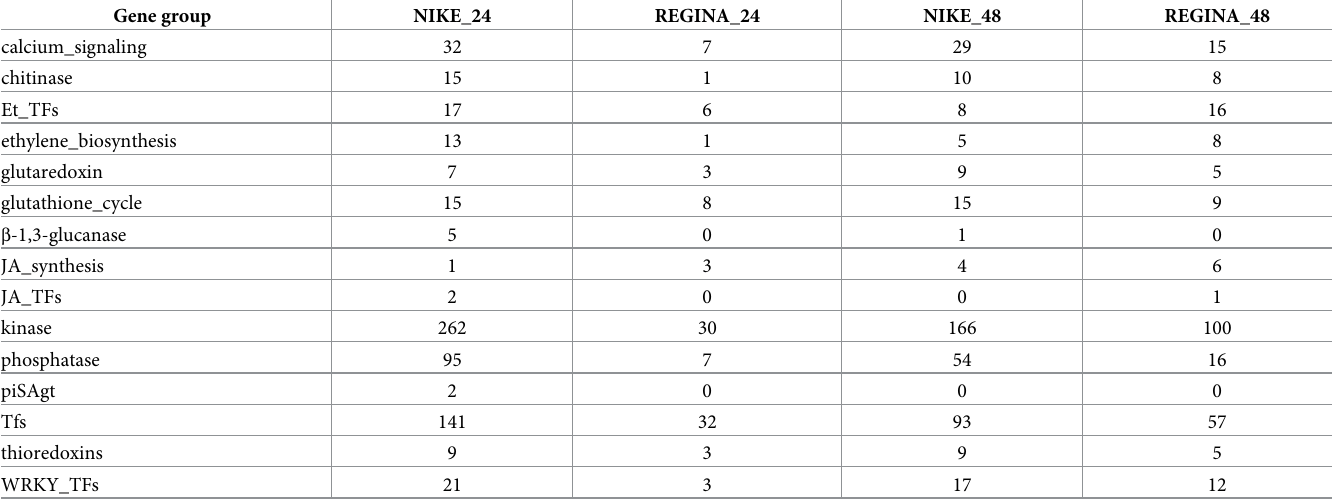
Table 1. Number of DEGs that appear uniquely in Nike and Regina at 24 hpi and 48 hpi in selected groups of genes. Gene